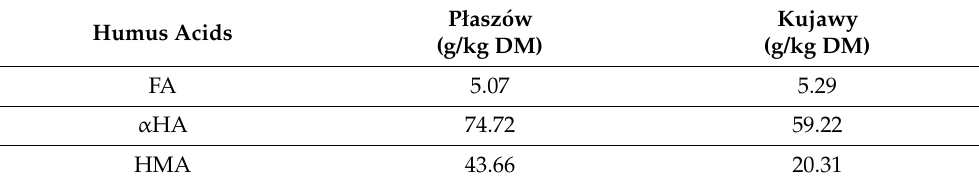
Table 5. Quantity of the extracted